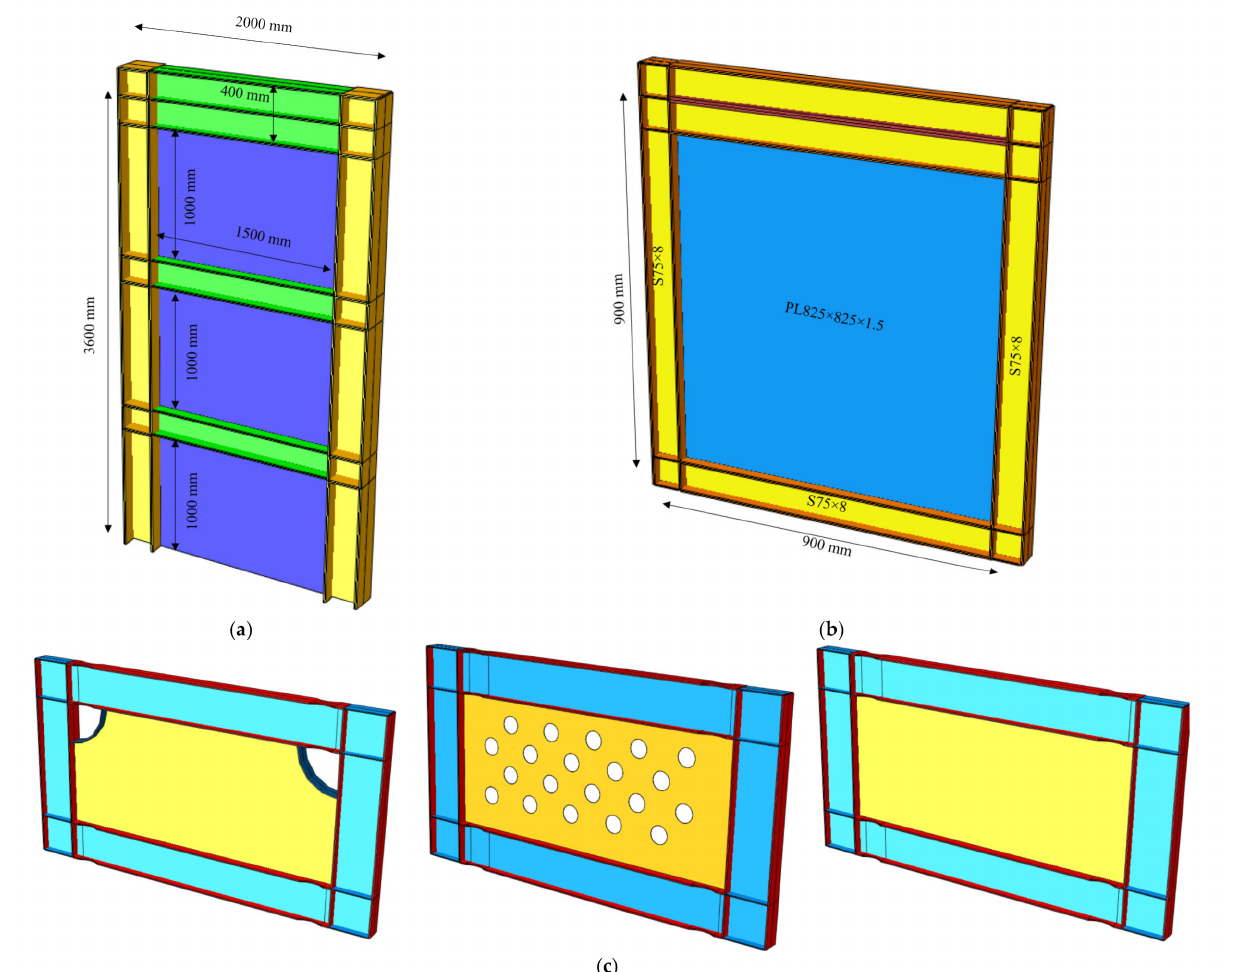
Figure 5. Selected experimental specimens for numerical simulations: ( a ) tested specimens by Park et al. [31], ( b ) specimen SPSW2 tested by Lubell [8], and ( c ) tested specimens by Vian et al.